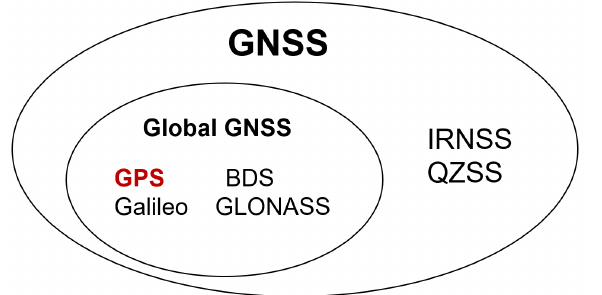
Figure 1. GNSS is a general term for a class of systems that mainly consists of four global positioning systems and two regional positioning systems. Among them, GPS is the most mature and widely used